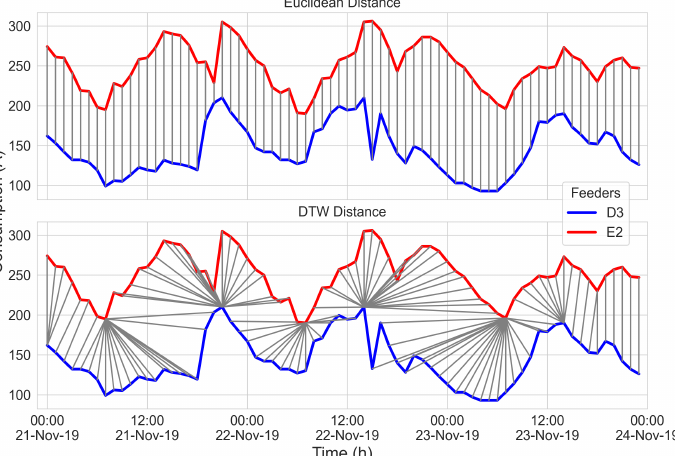
Figure 5. Euclidean. and DTW distance measurements applied to feeders D3 and